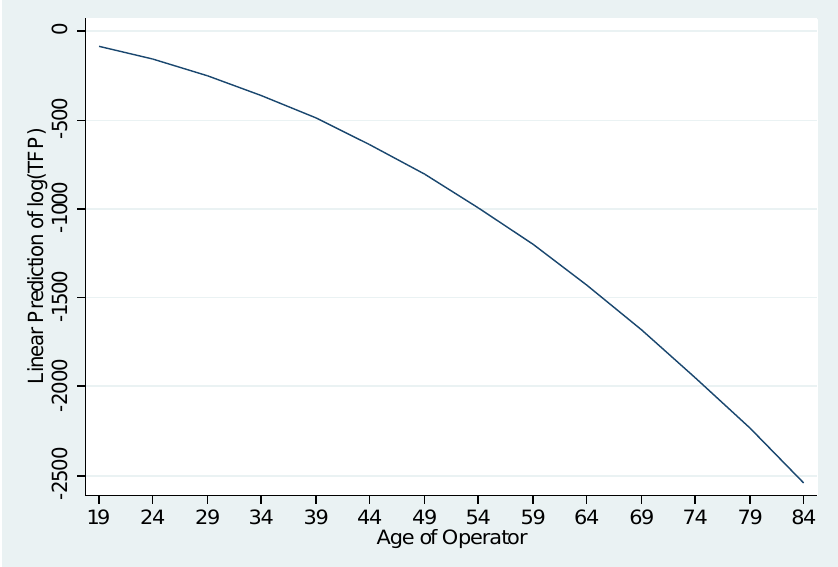
Figure 1. Predictive margins graph showing nonlinear relationship between age and Total Factor Productivity. Source: authors ’ computation based on FBS 2005 – 2016.